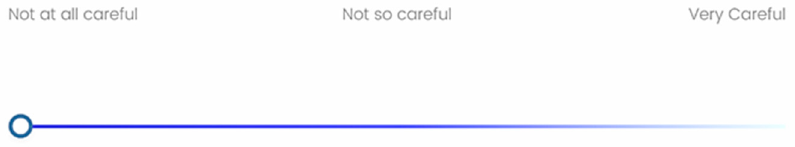
Figure 1. The monochromatic communication scheme.